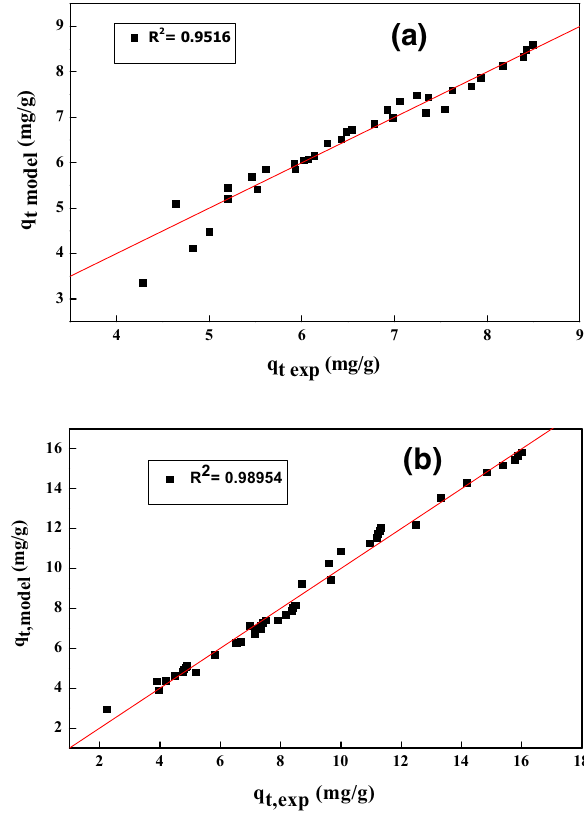
Fig. 11 Experimental versus predicted confrontations of the biosorp- tion capacity for the diazinon-PCE for different concentrations ( a ) and different temperatures ( b